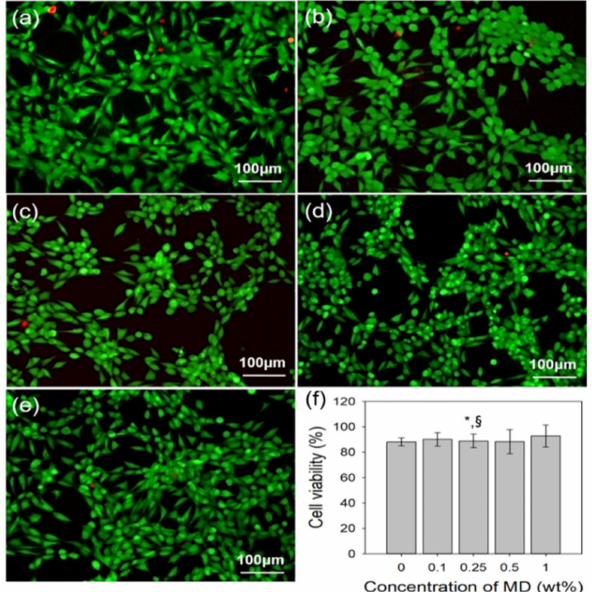
Figure 9. Live / Dead assay of NIH3T3 cells cultured on MD / PAA hydrogel films with di ff erent content of MD: ( a ) 0 wt%, ( b ) 0.1 wt%, ( c ) 0.25 wt%, ( d ) 0.5 wt%, and ( e ) 1 wt% irradiated at 25 kGy, and ( f ) cell viability of MD / PAA hydrogel film using WST-1 assay. (“*” indicates statistical significance relative to PAA, and “§” relative to the 0.1MD / PAA, with p <